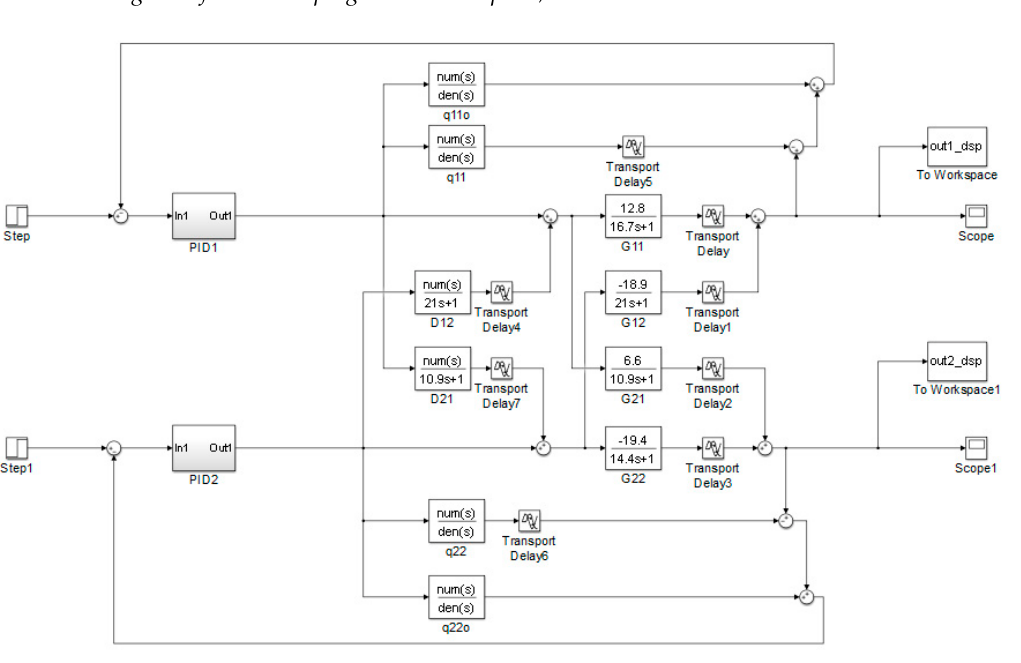
Figure A1. The implementing diagram of the DSP structure for WB column. Figure 24. The implementing diagram of the DSP structure for WB column The block diagram of Simulink program in Example 2, VL The block diagram of Simulink program in Example 2, VL column.